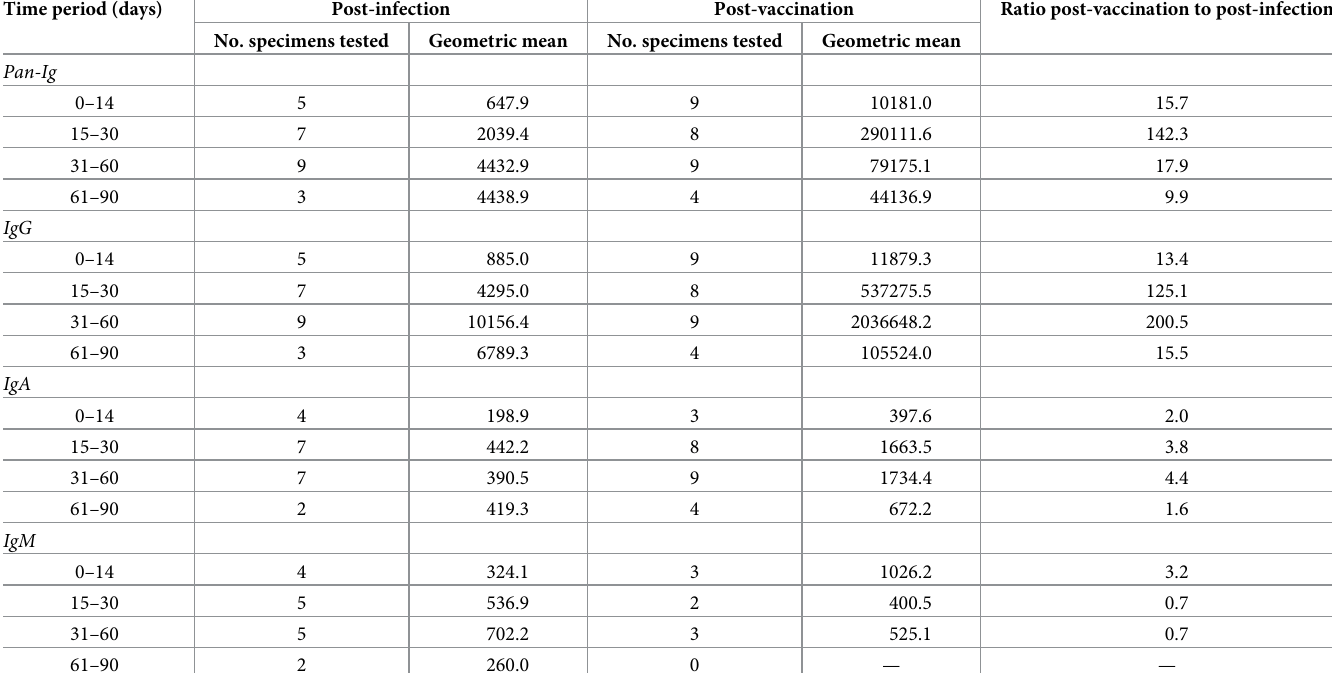
Table 2. Geometric means of anti–SARS-CoV-2 serum antibody titers and ratios post-vaccination and post-infection by isotype among participants (N = 11) in a nursing home cohort—Georgia, October 2020–April 2021 � ,† . Time period (days) Post-infection Post-vaccination Ratio post-vaccination to post-infection No. specimens tested Geometric mean No. specimens